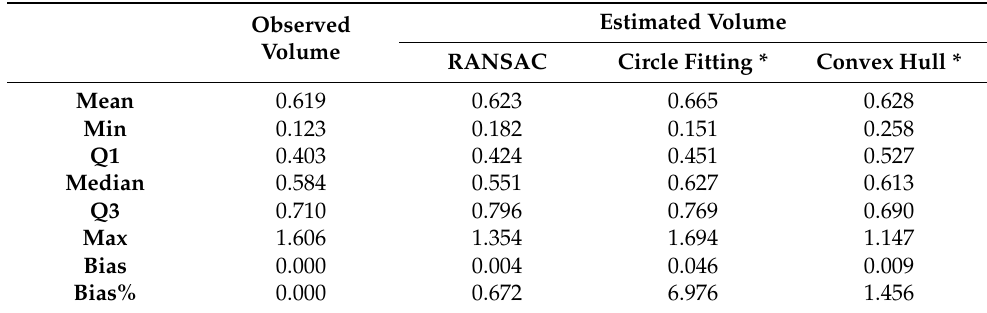
Table 6. Statistical summary of the observed and estimated total stem volume. Observed